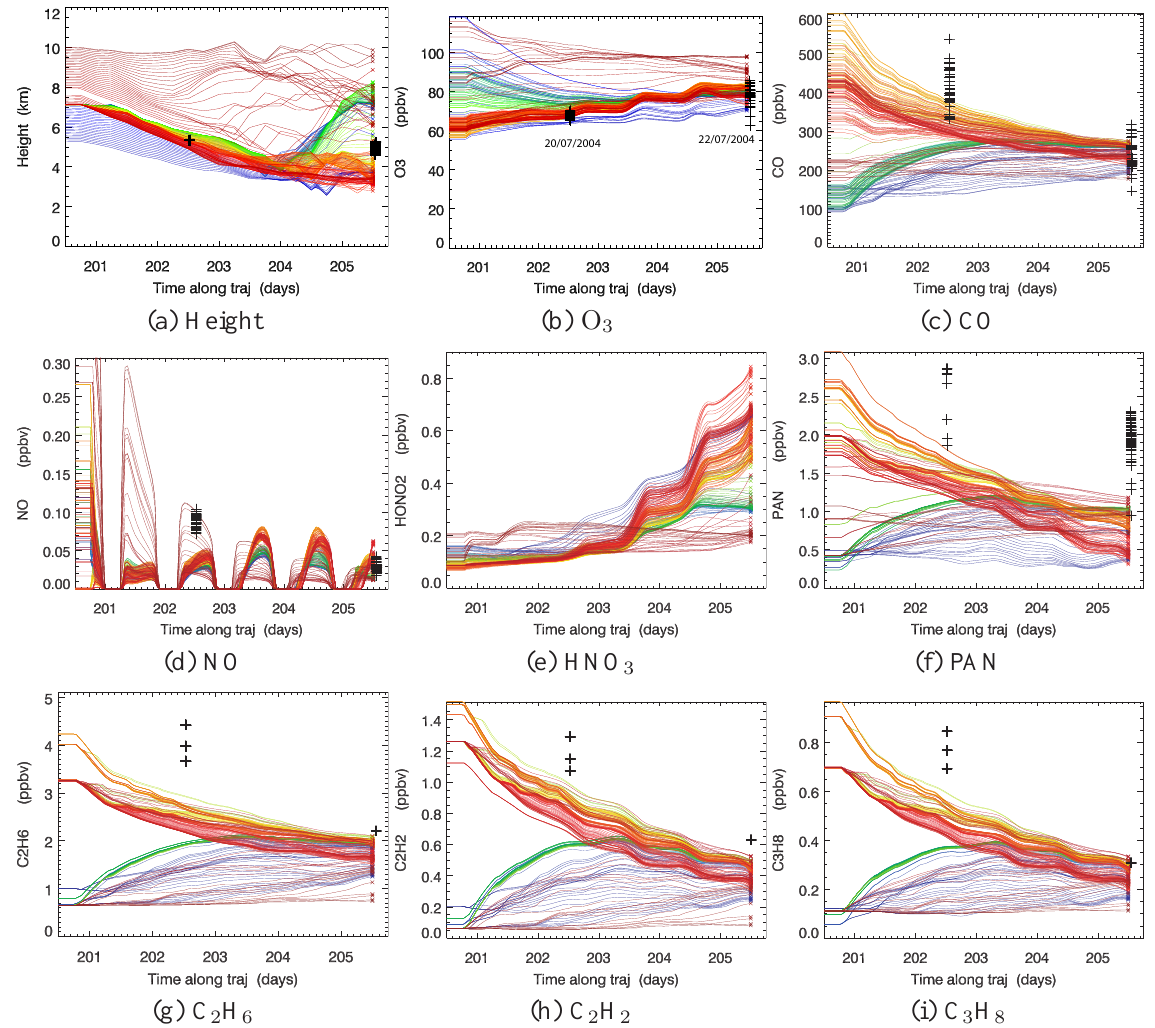
Fig. 2. Case 2 ensemble of trajectories for the control simulation. NO y observations from the DLR Falcon on day 205 are shown on the PAN plot. Trajectories are coloured by their release time from the flight track on 18 July 2004 so that individual trajectories can be distinguished. Blue trajectories are initialised immediately below the main plume; dark red above the main plume. Other details as in Fig. 1. a single trajectory Lagrangian model, as the result will vary depending on the trajectory